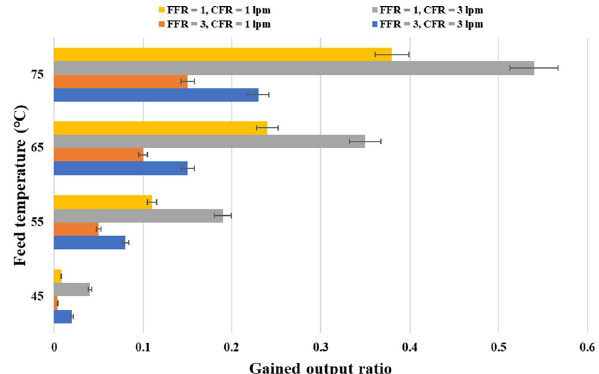
Fig. 14 Effect of length of the HAGMD module on permeate flux